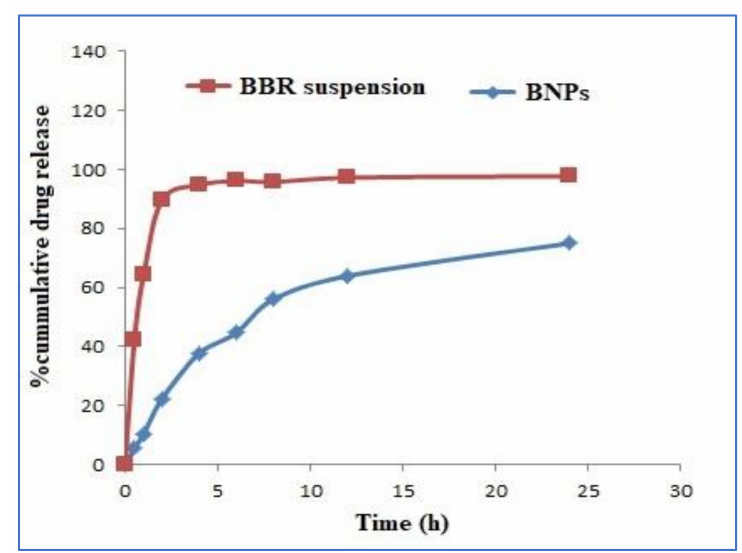
Figure 5. Cumulative release of BBR from BBR suspension and